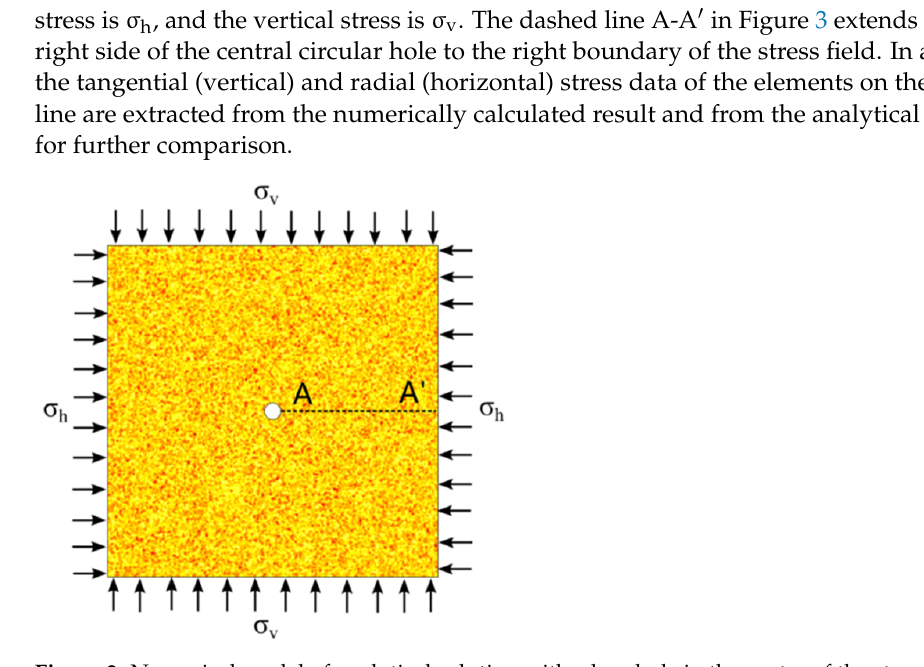
Figure 3. Numerical model of analytical solution with a borehole in the center of the stress field. The analytical solution of the elastic-plastic model with the M-C criterion, taking cohesion into account, can be described by: